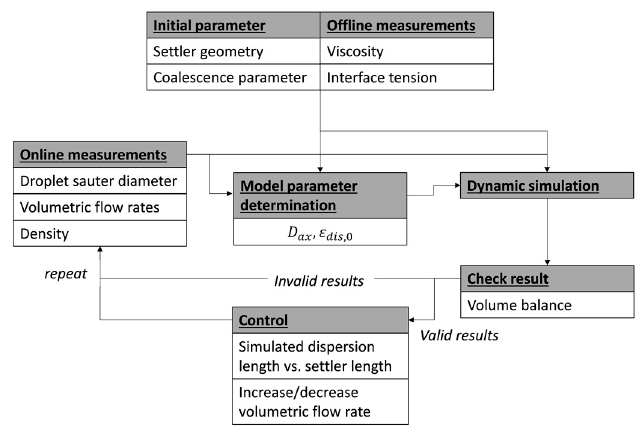
Figure 10. Flowchart of the digital twin operation.